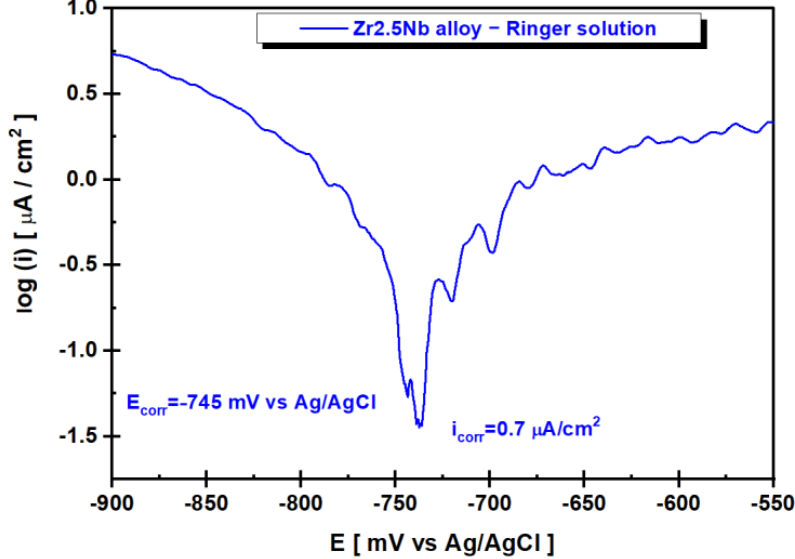
Figure 3. Linear polarization curve of Zr2.5Nb alloy immersed in Ringer’s solution drawn at a scanning speed of 3 mV/s.